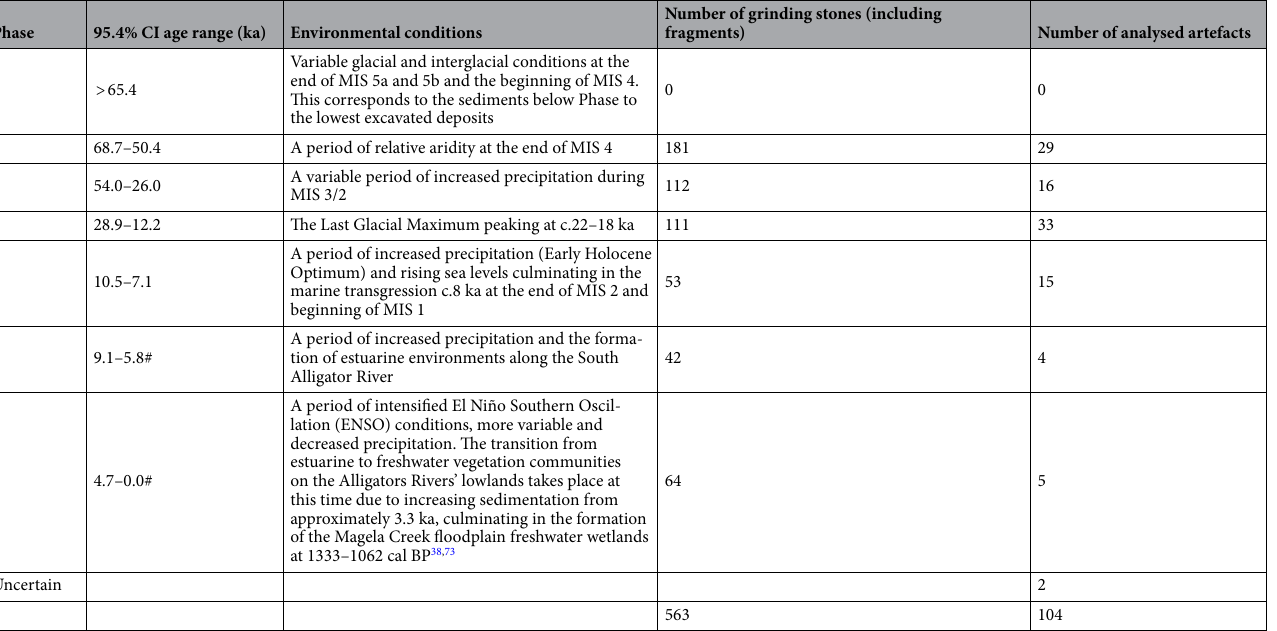
Table 1. The age range expressed as the 95.4% confidence interval (CI) obtained from the modelled start and end age estimates for the seven phases of the Madjedbebe sequence, corresponding MIS and climatic conditions 1,2,3 , and number of grinding stones (including fragments) recovered and analysed from each phase. #Age range for Phases 6 and 7 are based on the oldest and youngest OSL and/or 14 C